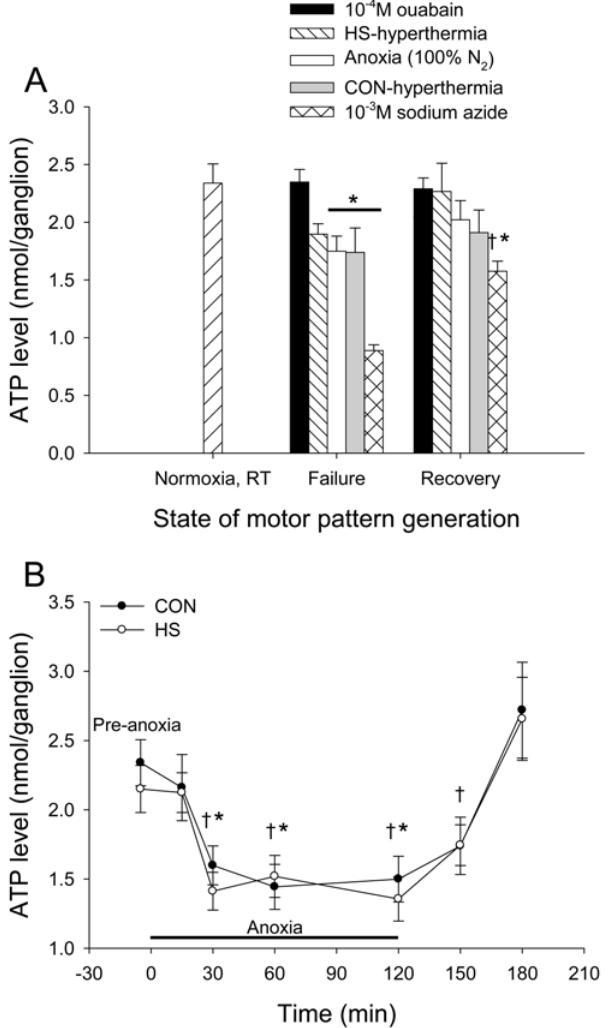
Figure 5. Failure and recovery of the CPG are not dependent on MTG ATP and HS preconditioning does not confer protection by improving ATP availability. A. ATP levels did not differ from the pre- stress level (Normoxia at room temperature; N=16) in locusts treated with 10 2 4 M ouabain or hyperthermia (HS) at failure or recovery, or in all other groups at recovery following stress-induced failure with the exception of NaN 3 -treated locusts. There was a main effect of treatment driven by significant differences among groups within failure and recovery (not indicated by symbols). There was no effect of HS pre- treatment on ATP levels at failure or recovery of motor pattern generation. Asterisks indicate significant differences from the pre-stress level and daggers indicate significantly different ATP levels at failure and recovery in ganglia of NaN 3 -treated locusts. Sample sizes (failure, recovery): N Ouabain =10,11; N HS-hyperthermia =8,8; N Anoxia =9,8; N CON-hyperthermia =7,7; N Sodium azide =8,9. B. CON and HS locusts did not have significantly different ATP levels during anoxia-induced coma or subsequent recovery. ATP levels dropped in both CON and HS locusts after 30 minutes of anoxia and remained stable until locusts were removed from the anoxic environment. ATP levels increased to around pre-anoxia values after one hour in normally oxygenated air. Sample sizes (CON, HS): N 0min =16,16; N 15min =12,11; N 30min =11,11; N 60min =9,9; N 120min =12,11; N 150min =11,12; N 180min =10,10. Asterisks indicate sig- nificant differences from 0 and 15 minutes and daggers indicate significant differences from 180 minutes (or 60 minutes